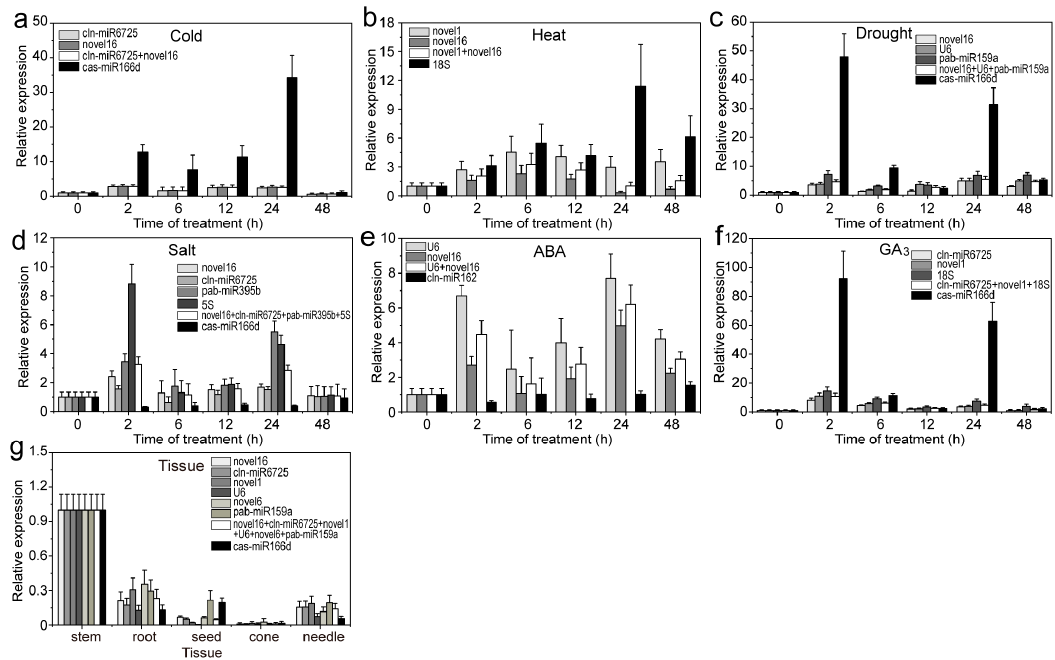
Figure 10. Relative expression levels of smo-miR396 under different experimental conditions. Results from ( a ) 4 °C cold stress; ( b ) 40 °C heat stress; ( c ) drought stress simulated by 15% PEG-6000 treatment; ( d ) salt stress stimulated by 200 mM NaCl treatment; ( e ) 200 μ M ABA treatment; ( f ) 200 μ M GA 3 treatment; ( g ) different tissues (roots, stems, tender needles, cones and seeds). Error bars represent standard deviations (SD) (n = 3).